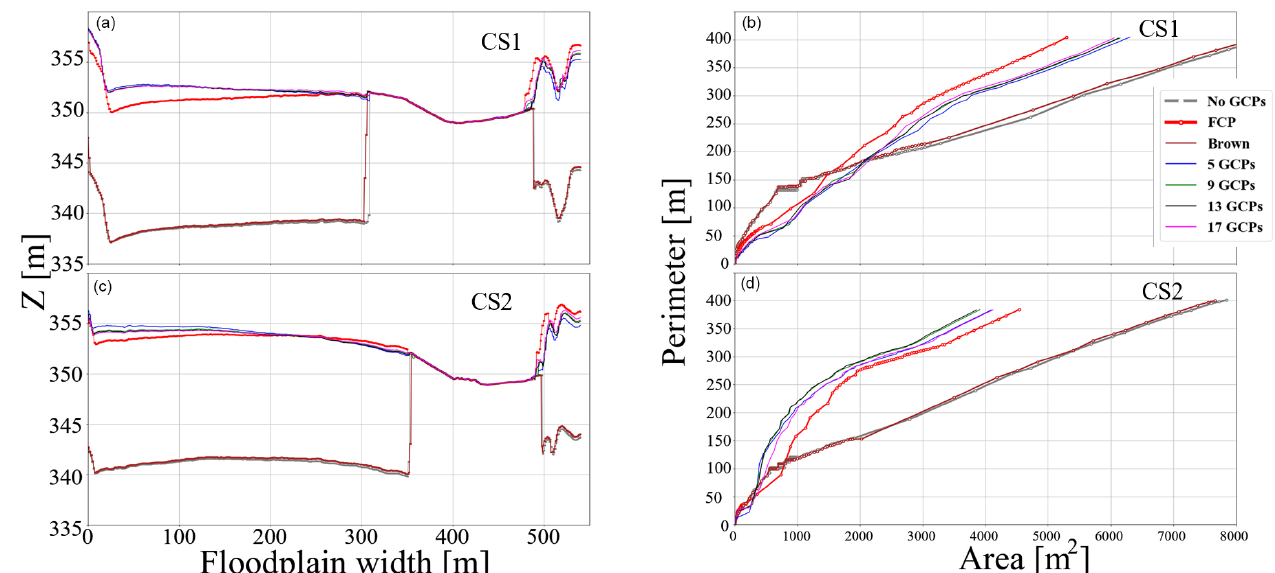
Figure B5. Height vs. width graph and perimeter vs.